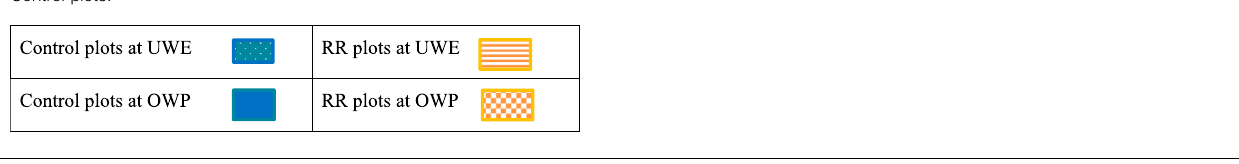
Frontiers in Environmental Science |